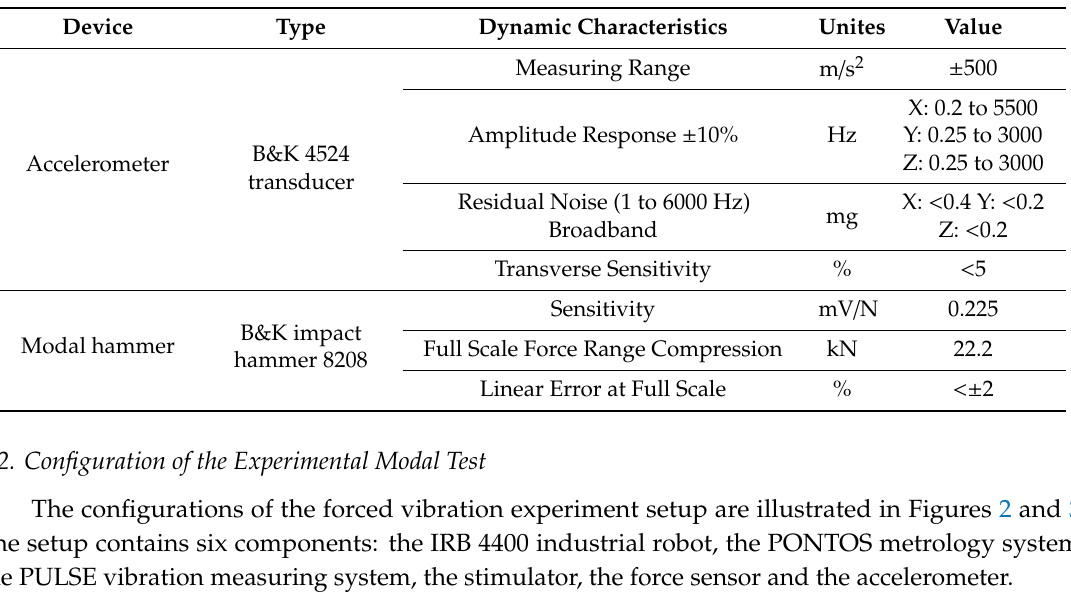
Table 1. Specifications of the accelerometer and the modal hammer [20,21].